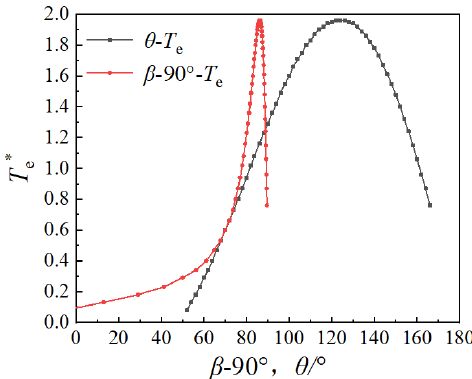
Figure 15. The curve of per unit value of torque at λ = 0.6.